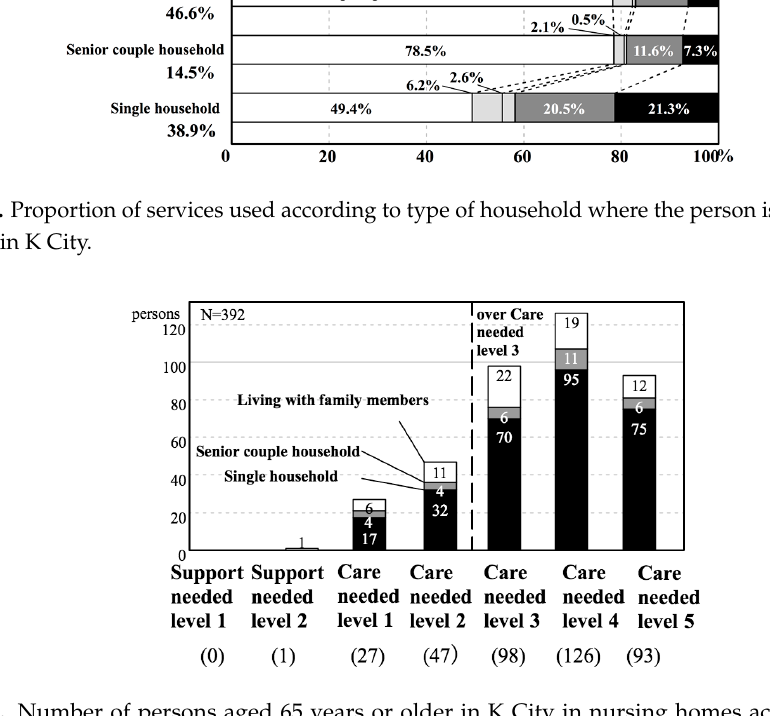
Figure 8. Actual situation regarding the capacity and the number of users for each type of facility in K city.